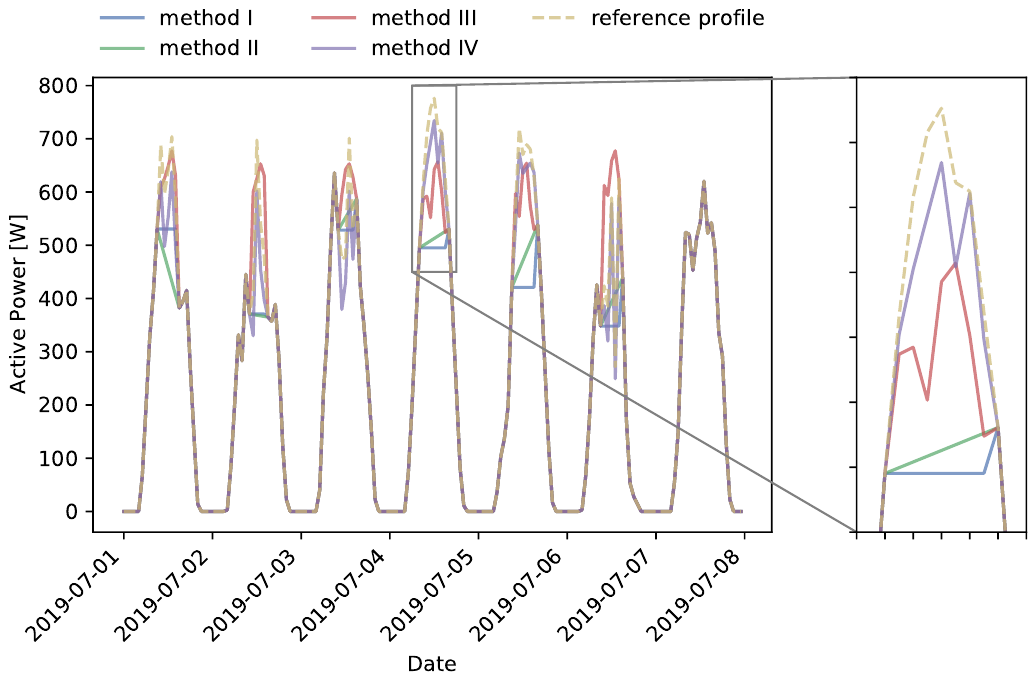
Figure 13. Comparing different baselining methods for curtailment option